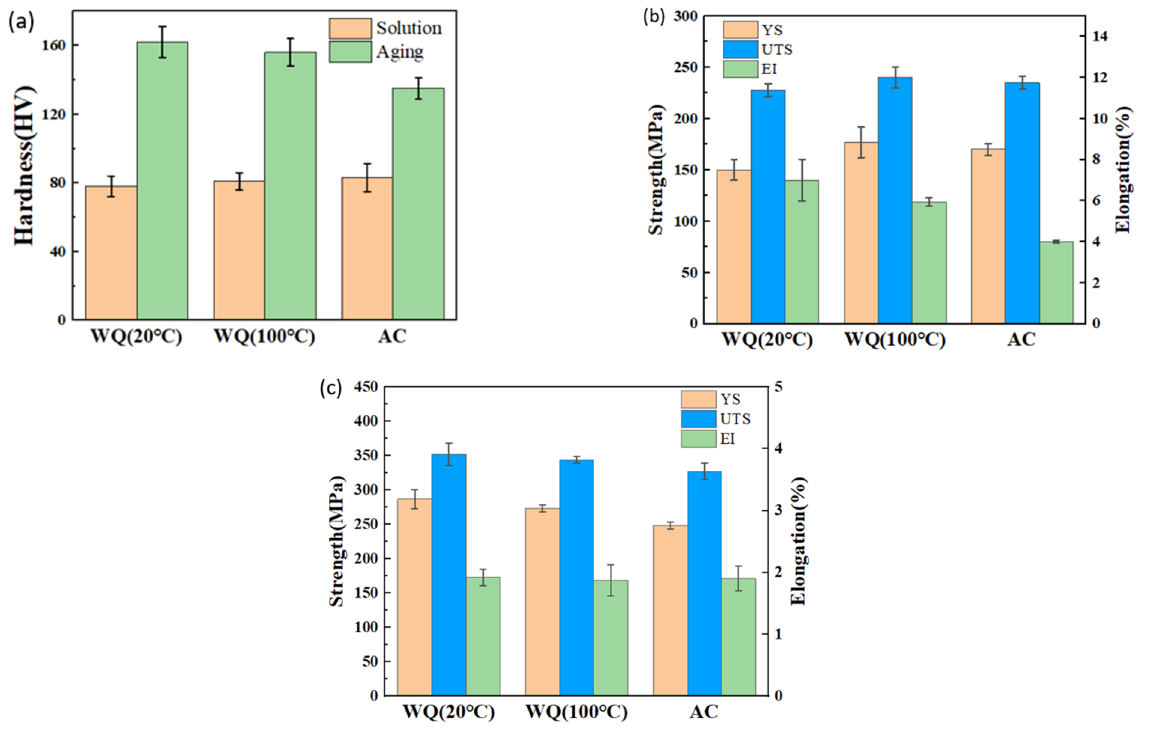
Figure 16. ( a ) Hardness in quenching and aging state ( b ) strength in quenching state ( c ) strength in aging state.